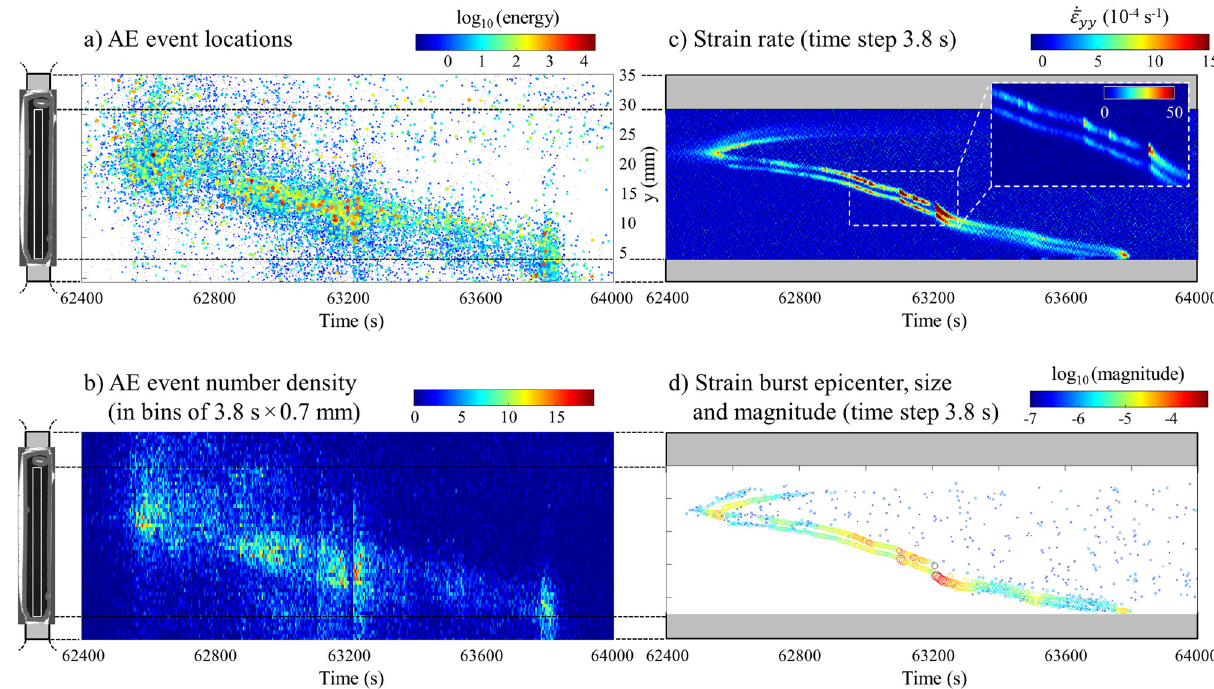
Fig. 4 Strain-rate data and AE data on the sample and along the transformation plateau, plotted on the ( t , y )-plane. a AE event locations and energies. b Number density of localised AE events derived from the map in panel a , in bins of dimensions 0.7 mm × 3.8 s. c Pro fi les in y of the x -averaged strain-rate _ ε t . Inset: detail of the austenite/martensite front propagation. d Epicenters of 1D strain-bursts, with associated size and magnitude (size yy for each time represented by circle radius).